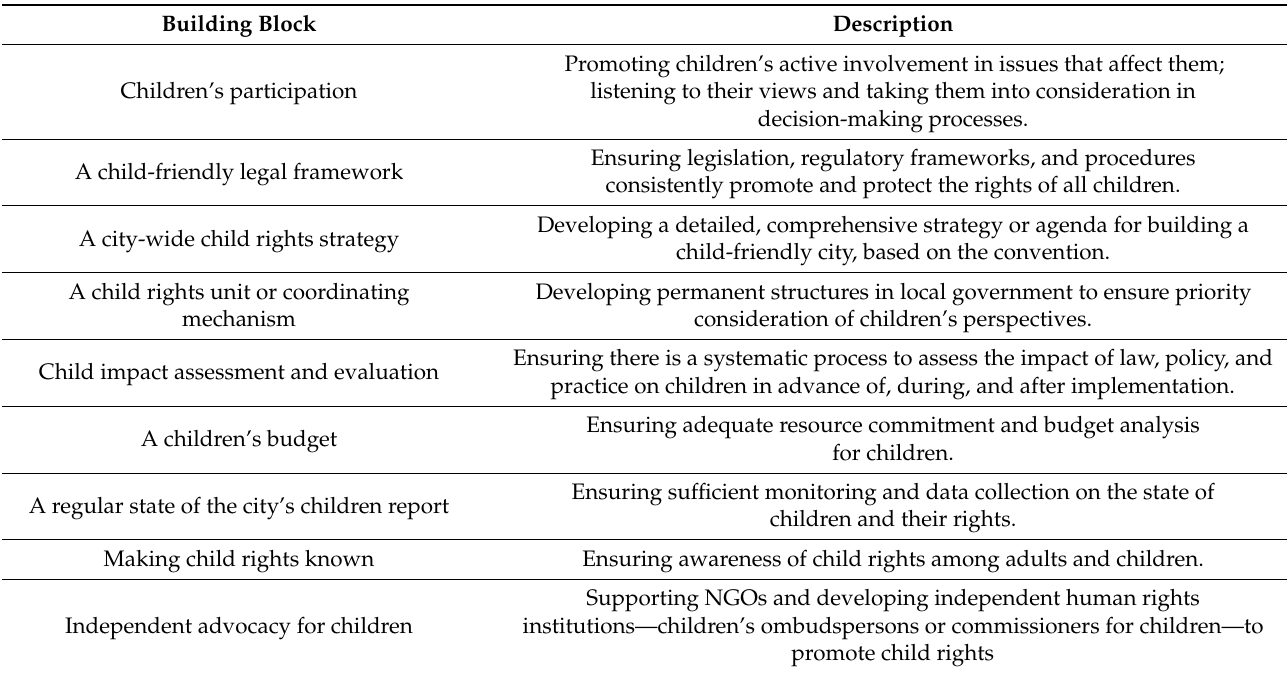
Table 1. Building blocks for developing child-friendly cities and